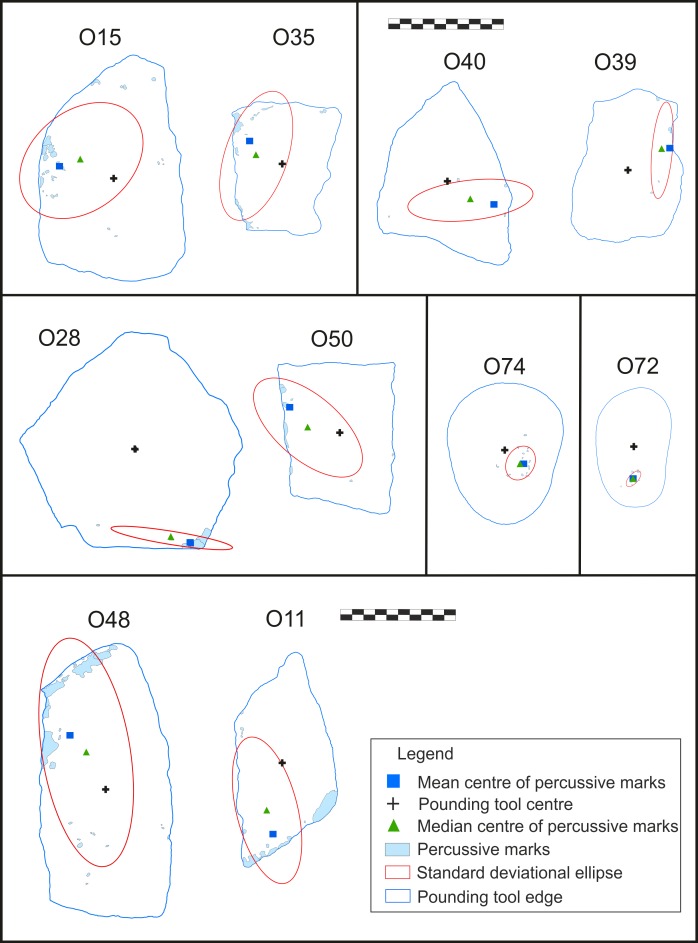
Spatial distribution analysis of pounding tools used in the experimental programme (see S1 Table for details).Analysis was not conducted on lava tools O74 and O128, as they did not develop macroscopic traces.